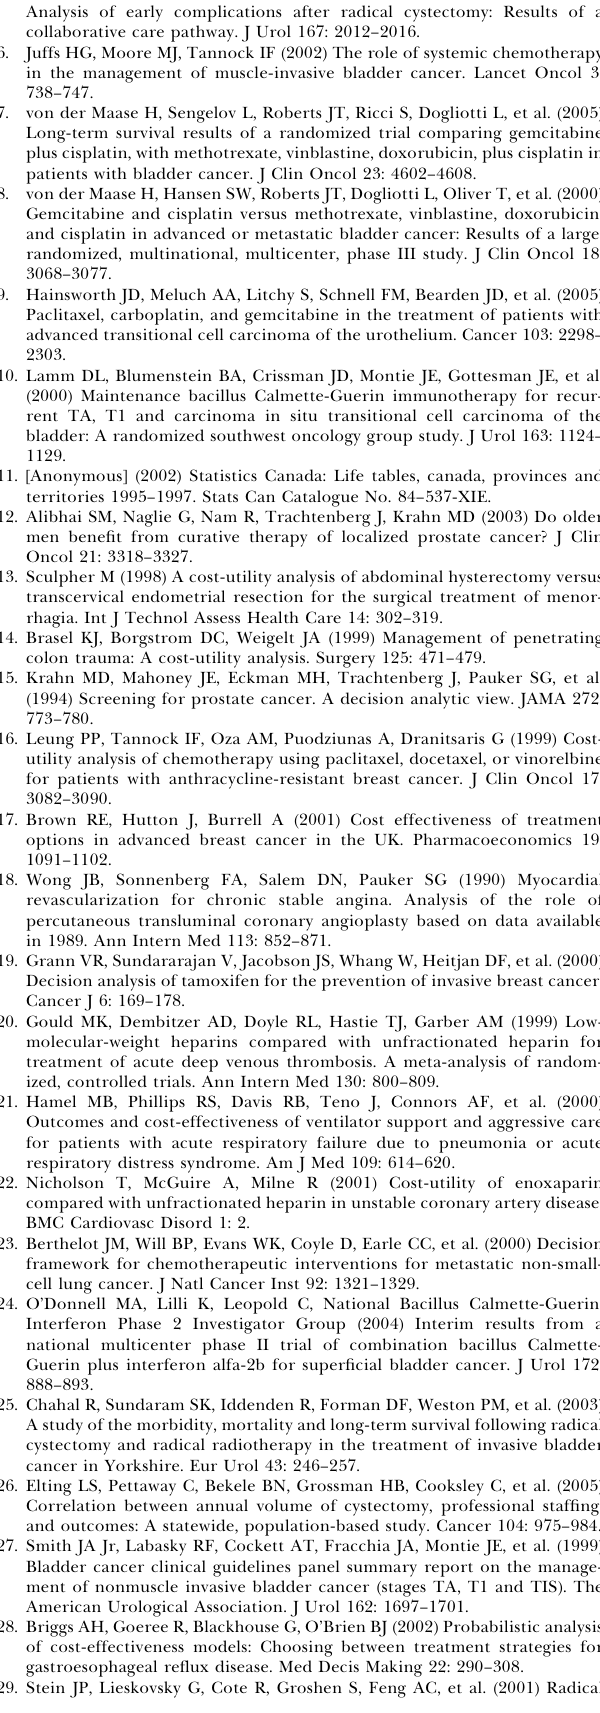
Table S1. Model Semiannual Probabilities and Utilities Semiannual probabilities and the utilities/disutilities used to populate the decision model. Found at doi:10.1371/journal.pmed.0040284.st001 (128 KB